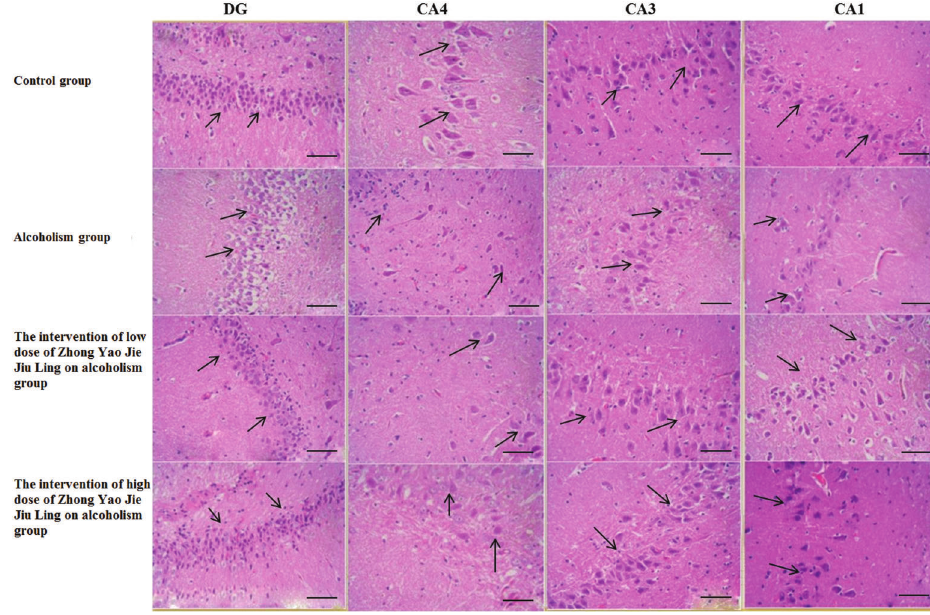
Figure 1. Hematoxylin-eosin (HE) staining of the dentate gyrus (DG) and hippocampus (CA4, CA3, and CA1) in the four groups (bars: 100 m m). The arrows indicate neurons.